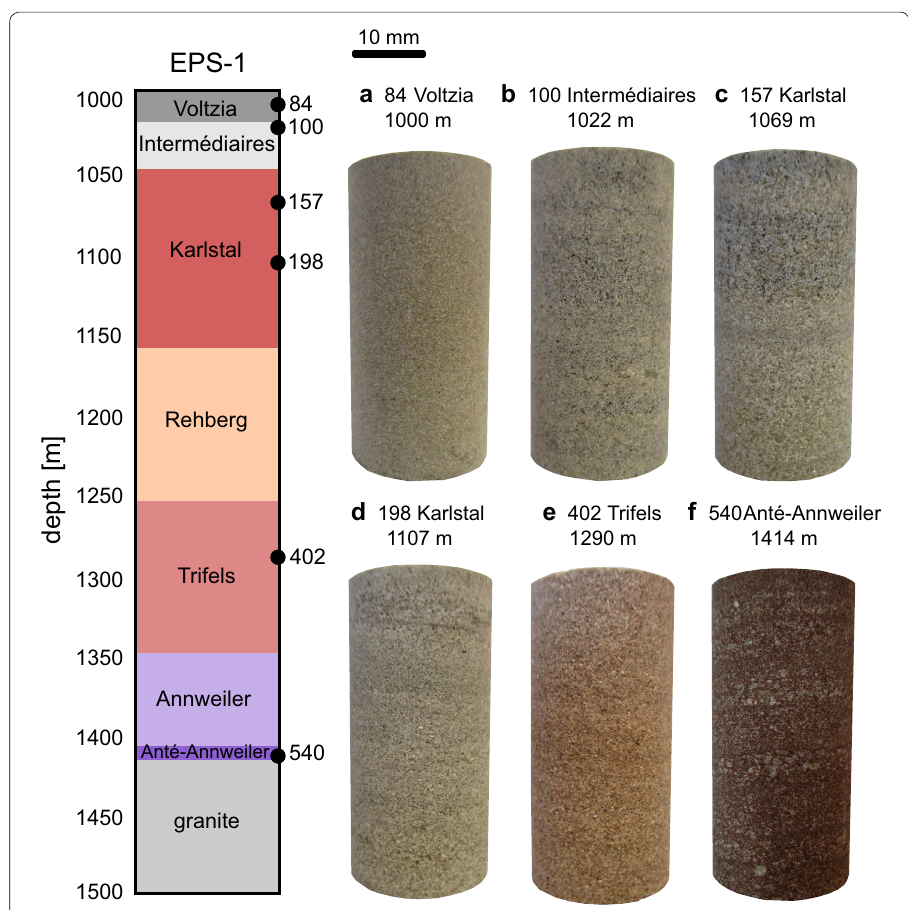
Fig. 2 Photographs of the six sandstones (20 mm-diameter core samples nominally 40 mm in length) sampled from exploration well EPS-1 at Soultz-sous-Forêts (France). The box number, lithological unit, and depth are given above each sample. A stratigraphic column showing the units within the Buntsandstein from exploration well EPS-1 at Soultz-sous-Forêts (Alsace, France) is shown on the left hand side. The locations for each of the sampled depths are indicated on the stratigraphic